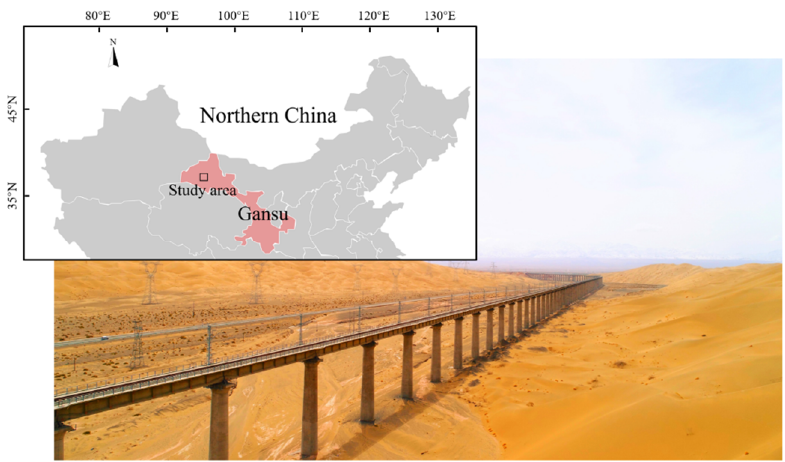
Figure 1. Dun-Gel railway project in Dunhuang city, Gansu Province, China.